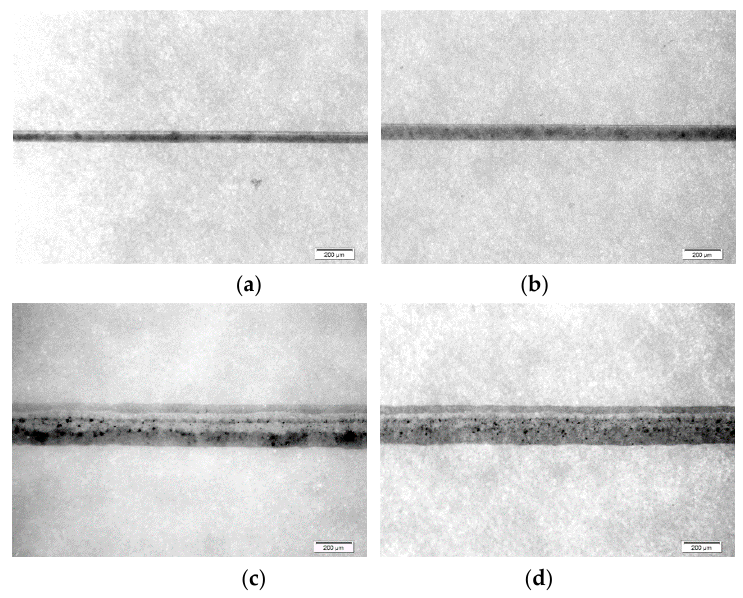
Figure 21. Lines of 0.03 mm nominal value fine lines printed by modified plates: ( a ) photopolymer 10 × , methoxypropanol, ( b ) photopolymer 30 × , methoxypropanol, ( c ) EPDM 10 × , IPA, ( d ) EPDM 30 × , IPA.